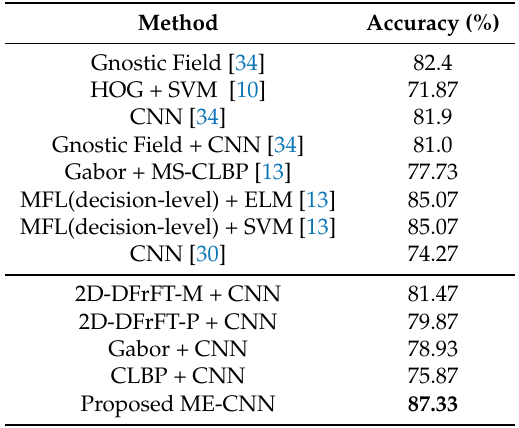
Table 7. Comparison of classification accuracy (%) with some state-of-the-art methods for the VAIS data.